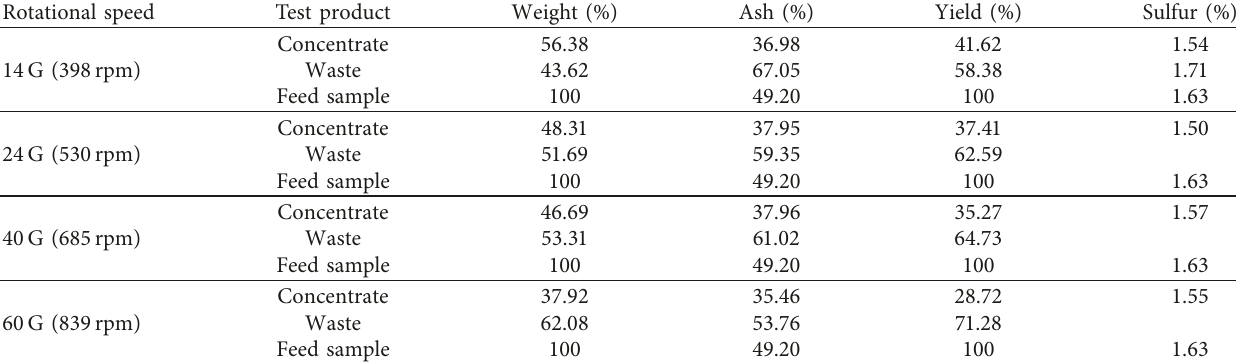
Feeds in the experiments are 130g each.